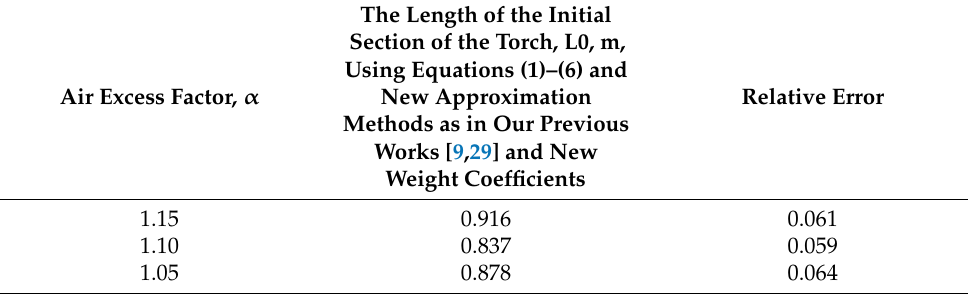
Air Excess Factor,